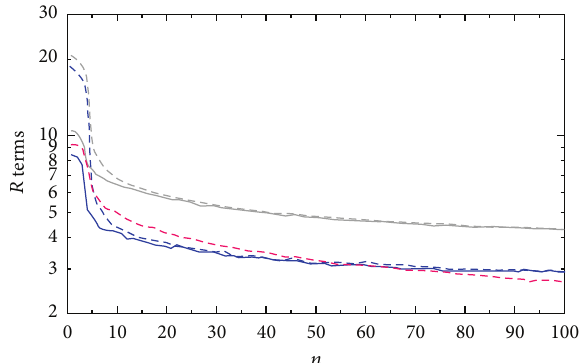
Figure 12: As in Figure 10 but the gray, red, and blue solid curves -30s NB, respectively, for the plot 𝑅 -30s NB, 𝑅 𝜂 -30s NB, and 𝑅 vr retrieval from the first step of Expt-NB (instead of